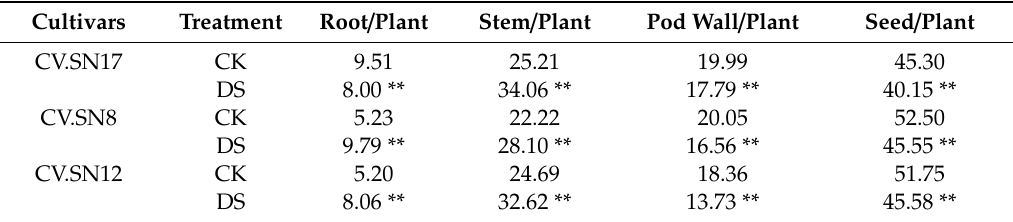
Table 3. Biomass proportion (%) of soybean root, stem, pod wall, and seed under drought